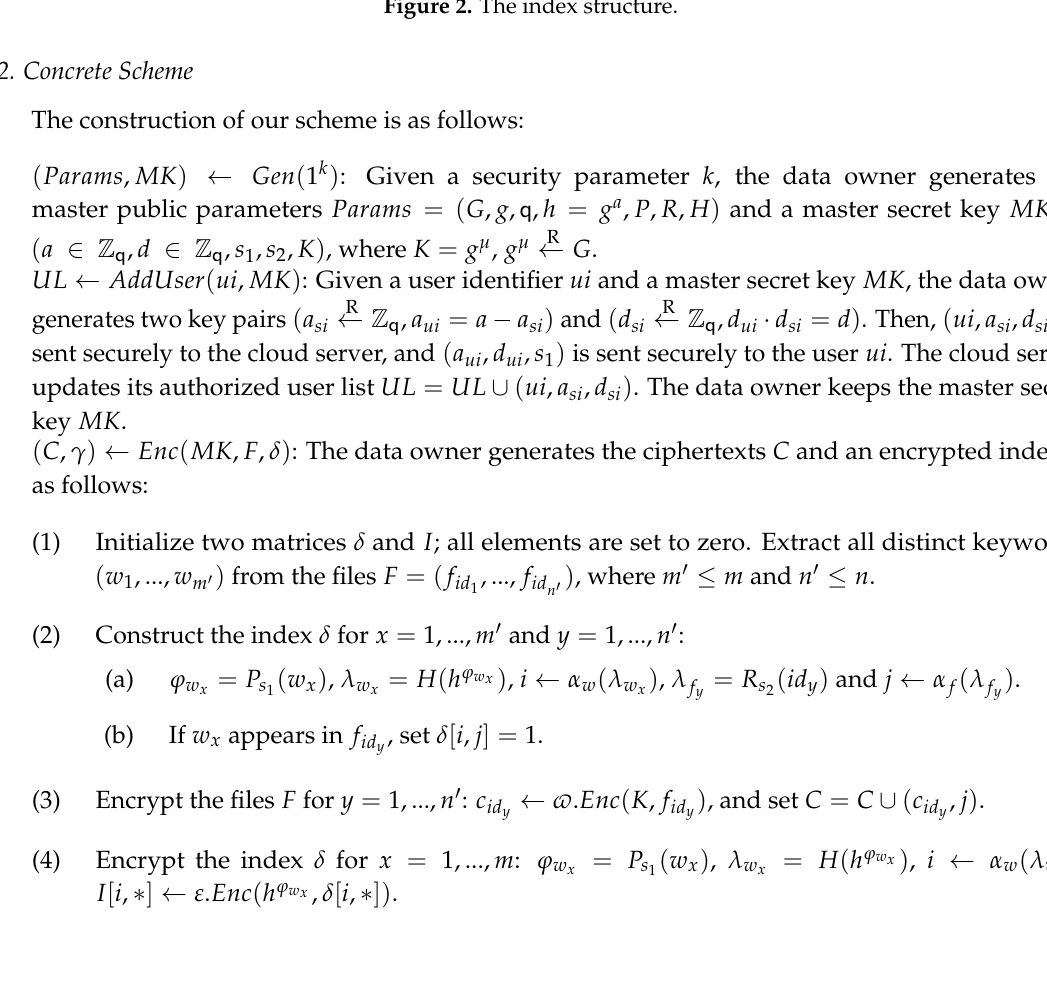
Figure 2. The index